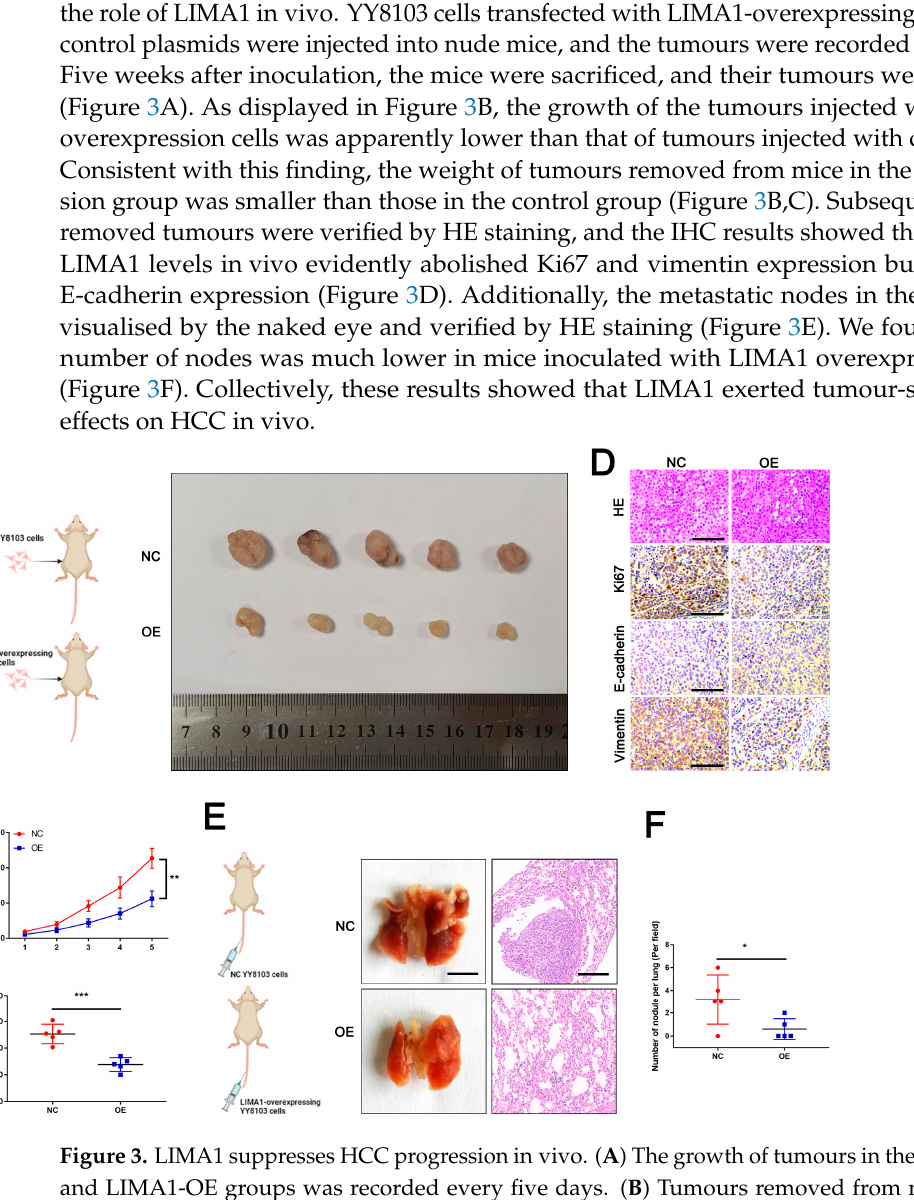
Figure 2. LIMA1 suppresses HCC cell malignant phenotypes in vitro. ( A ) CCK-8, ( B ) colony for- mation, and ( C ) EdU assays were performed to examine the effects of LIMA1 on proliferation. ( D ) Transwell assays were performed to examine the effects of LIMA1 on invasion and migration. Im- munofluorescence for vimentin ( E ) and western blotting ( F ) for vimentin and E-cadherin were per- formed to detect the role of LIMA1 in EMT progression. (NC, normal control; OE, LIMA1 overex- pression). * p < 0.05, ** p < 0.01.